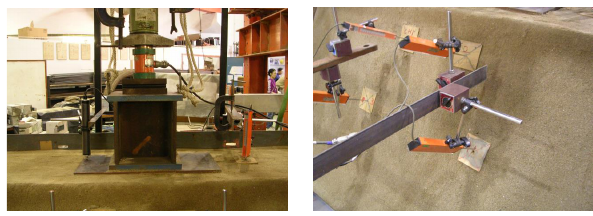
Figure5 LVDT at top and sloping face of the model test Figure 5. LVDT at the top and sloping face of the model